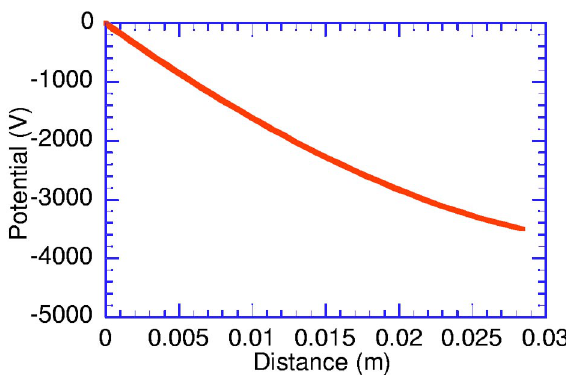
FIG. 5. (Color) Monotonic potential distribution. Beam energy is 5500 eV and the retarding voltage is (cid:7) 3500 V